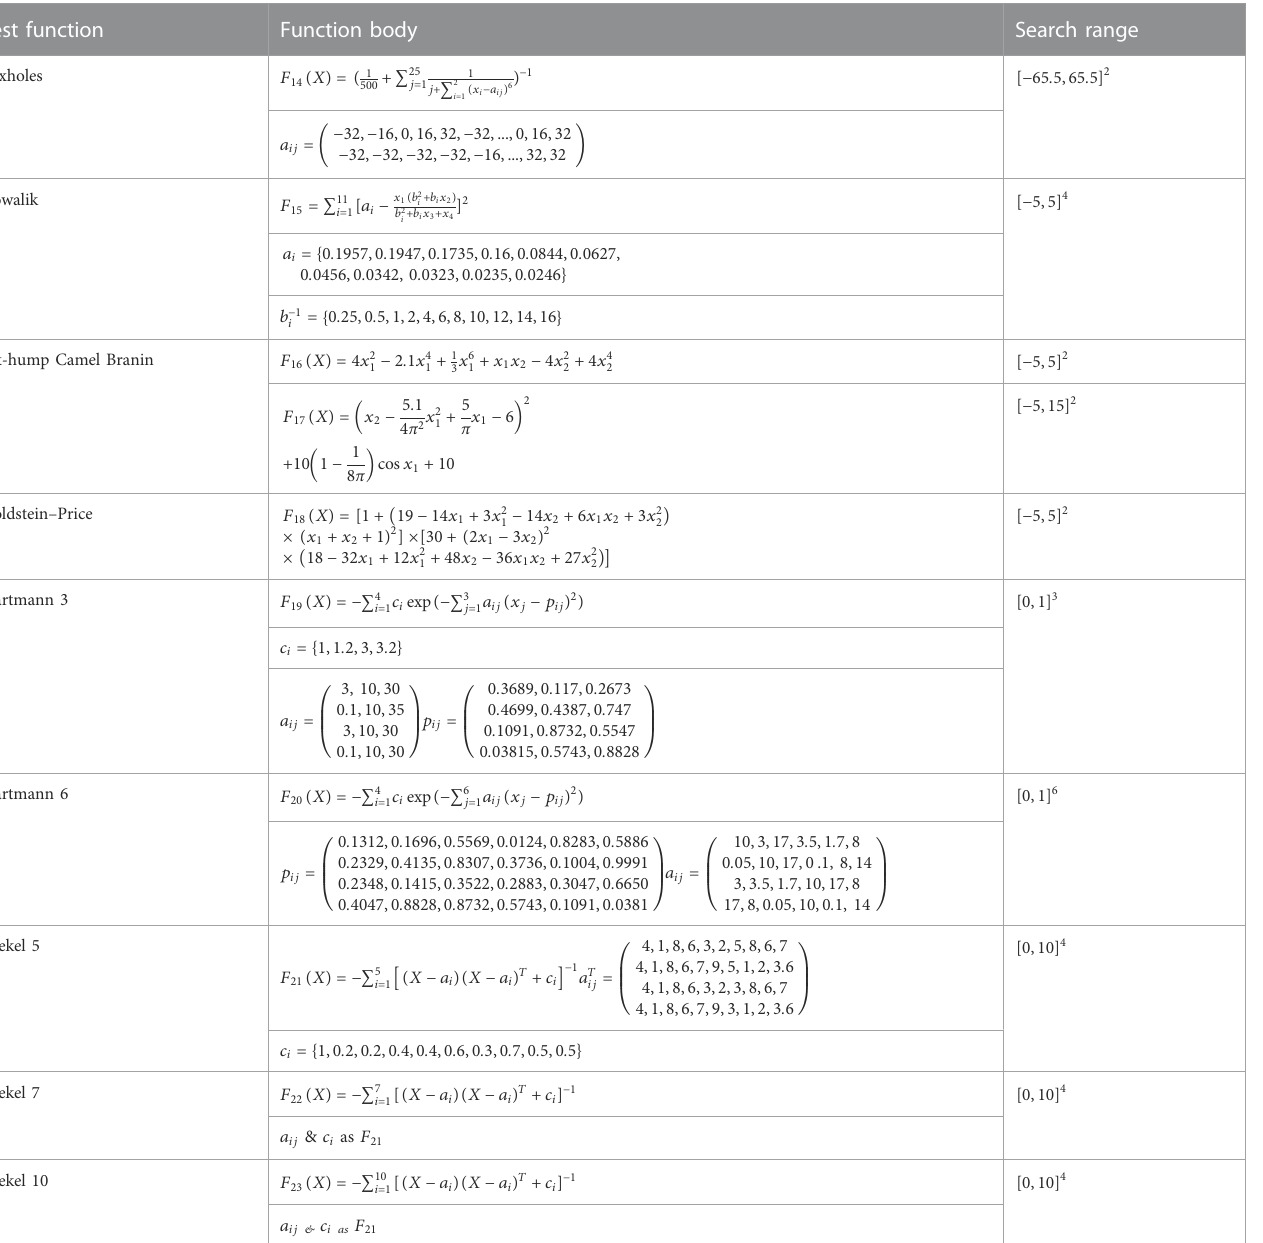
TABLE 3 Multimodal test functions with fi xed dimensionality. Test function Function body Search